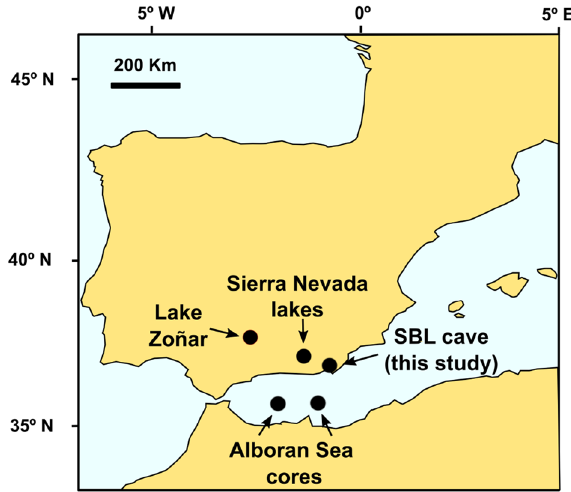
Figure 1. Main regional paleoclimate records mentioned in this study. This includes Sima Blanca cave (SBL cave, this study); Lake Zoñar 30–33 ; alpine lakes of Sierra Nevada 26,34–38,41,47 and Alboran Sea sediment cores, ODP Site 976 and 300G 32 . Figure created by InkScape 0.92.4 (https ://inksc